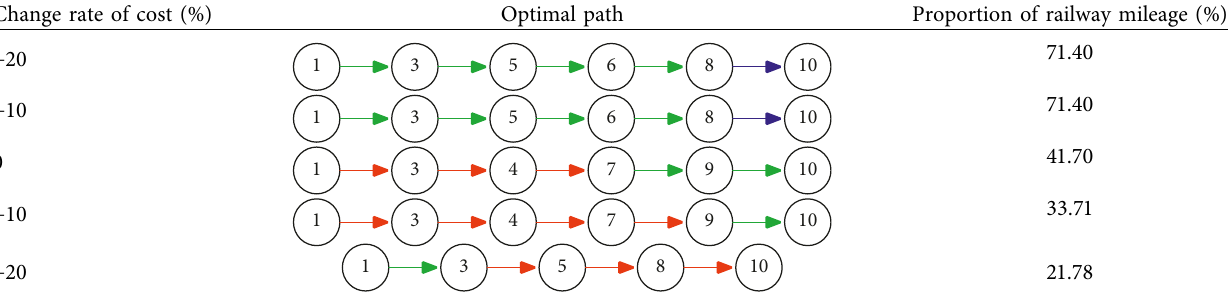
Table 8: Changes in the optimal path with railway transport